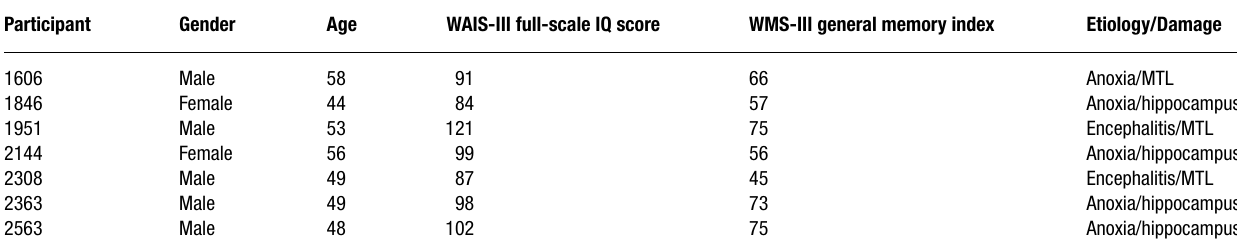
Table 1 | Demographics and memory scores for the amnesic patients at the time of testing.